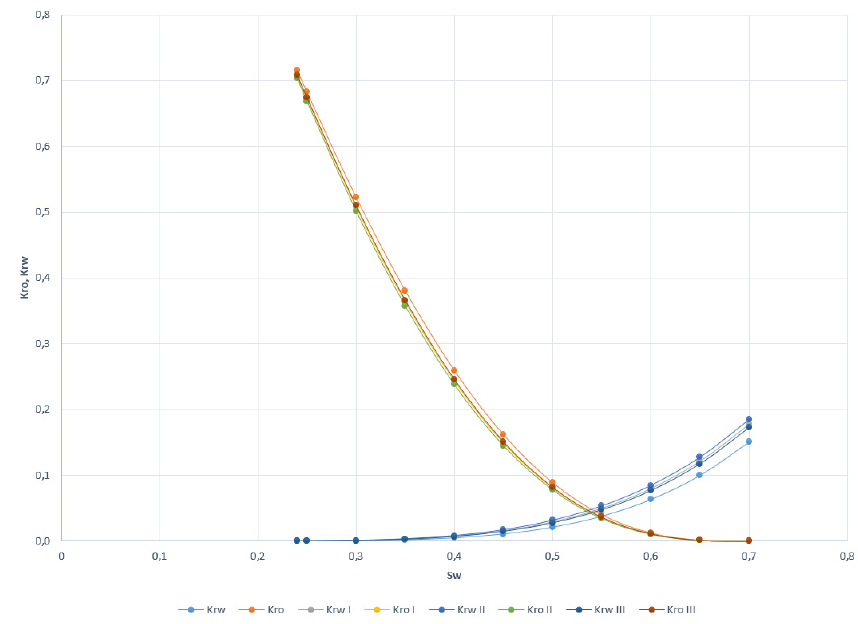
Figure 6. Calculated changes of relative permeabilities.